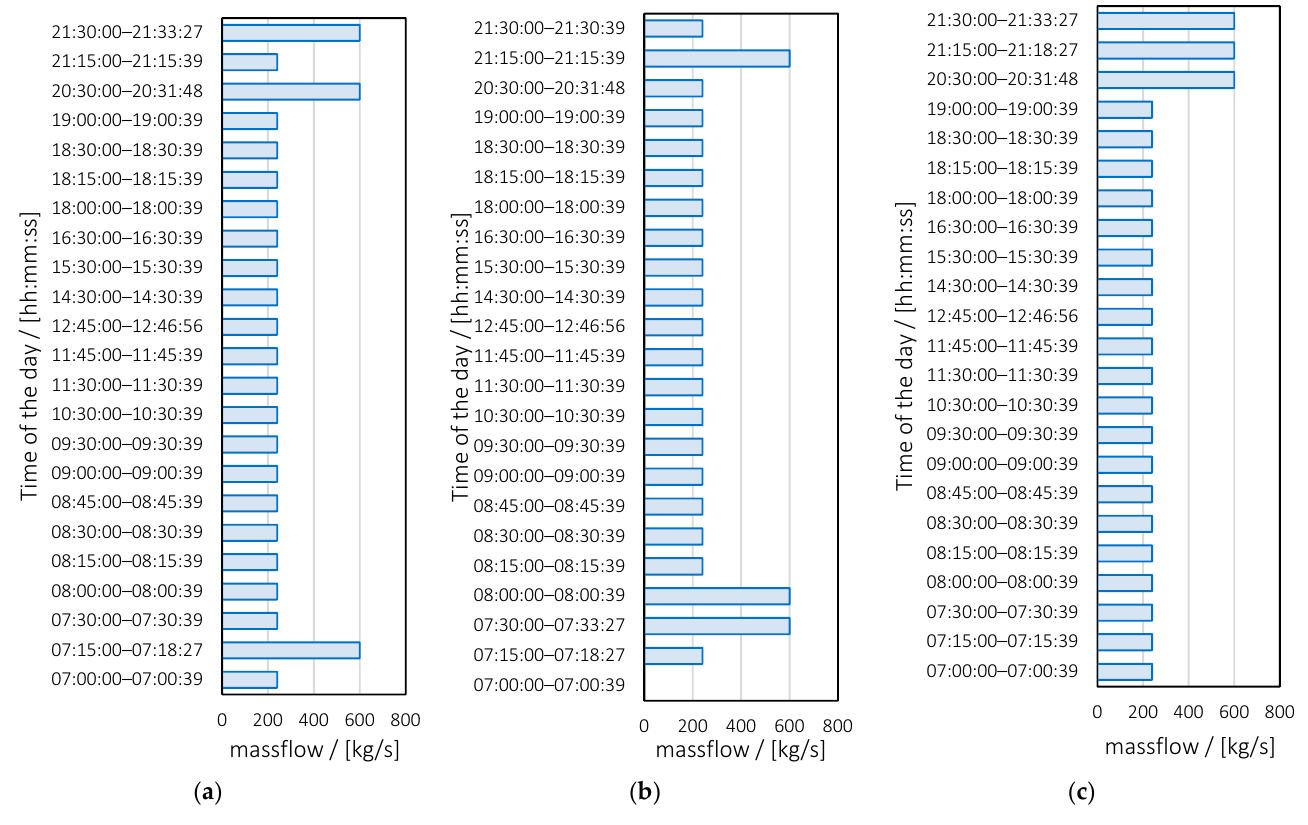
Figure A1. Domestic Hot Water (DHW) profiles (based on [34]) for the cases: ( a ) DHW1, ( b ) DHW2, and ( c ) DHW3.